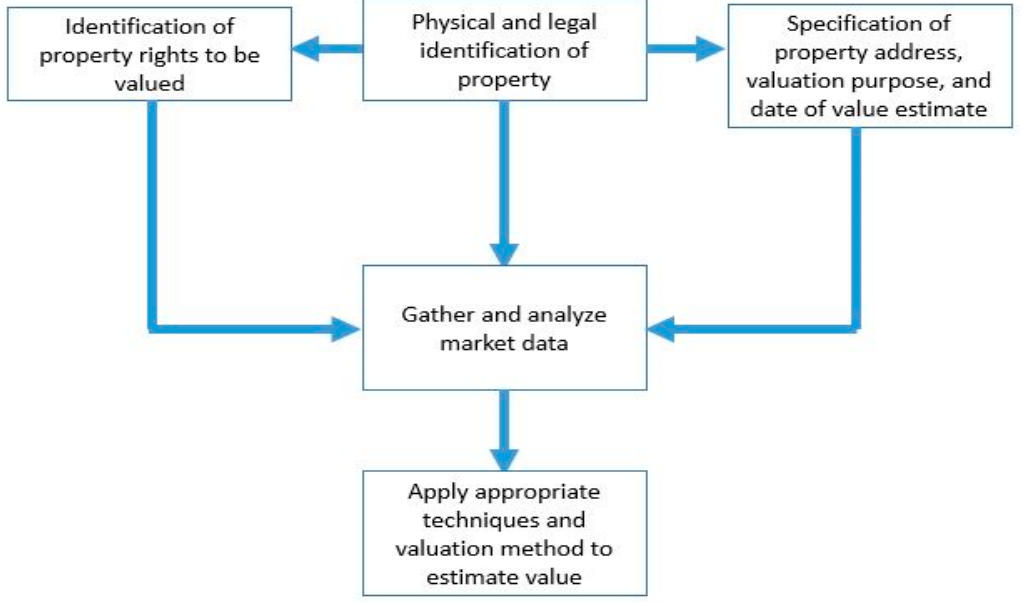
Figure 4. Land valuation process. Authors’ construct.